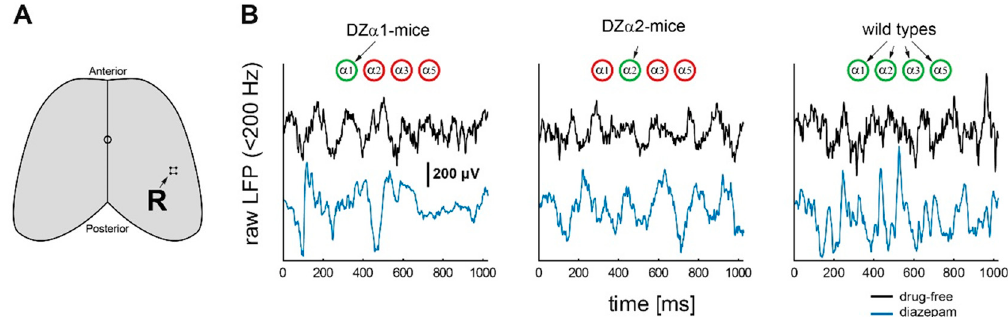
Figure 2. ( A ) Time series of electrocortical activity were recorded with an array of 4 electrodes which was chronically implanted in the cortex at a depth of 500 µ m. R: The site of recording (bregma P 1.8 and L 3.5). ( B ) Representative local field potential signals under drug-free conditions (black traces) and after intraperitoneal administration of diazepam at a concentration of 10 mg / kg body weight (blue traces). Signals were band-pass filtered, using cutoff frequencies of 1 and 200 Hz, respectively.